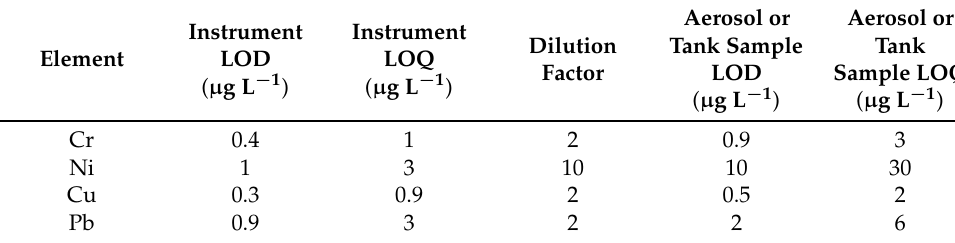
Table A1. Limits of detection (LOD) and quantitation (LOQ) of the elements analyzed in this study. Values are rounded to one significant